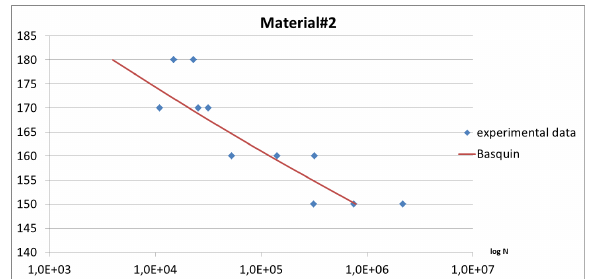
Figure 3. Applied fatigue models for Material#2.